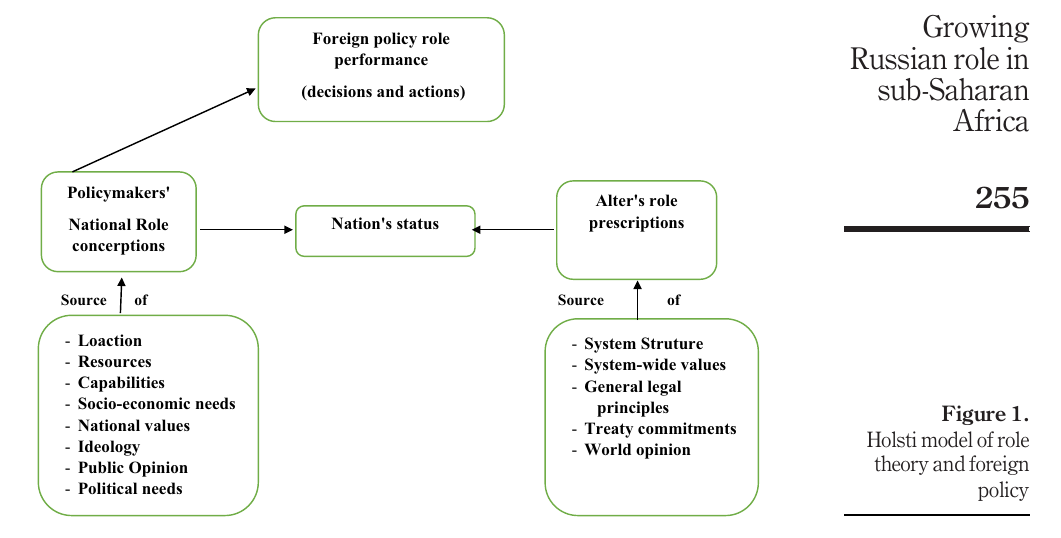
Figure 1. Holsti model of